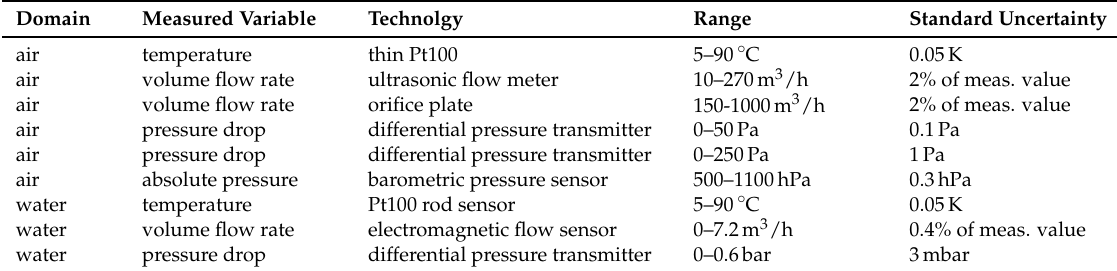
Table A1. Major sensor technology installed at test rig for heat exchangers [7]. Standard uncertainty has rectangular distribution.